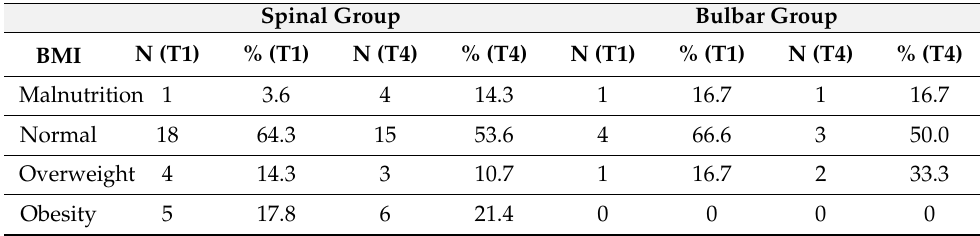
Table 2. Classification of the nutritional status, according to the BMI, according to diagnostic groups. Spinal Group Bulbar